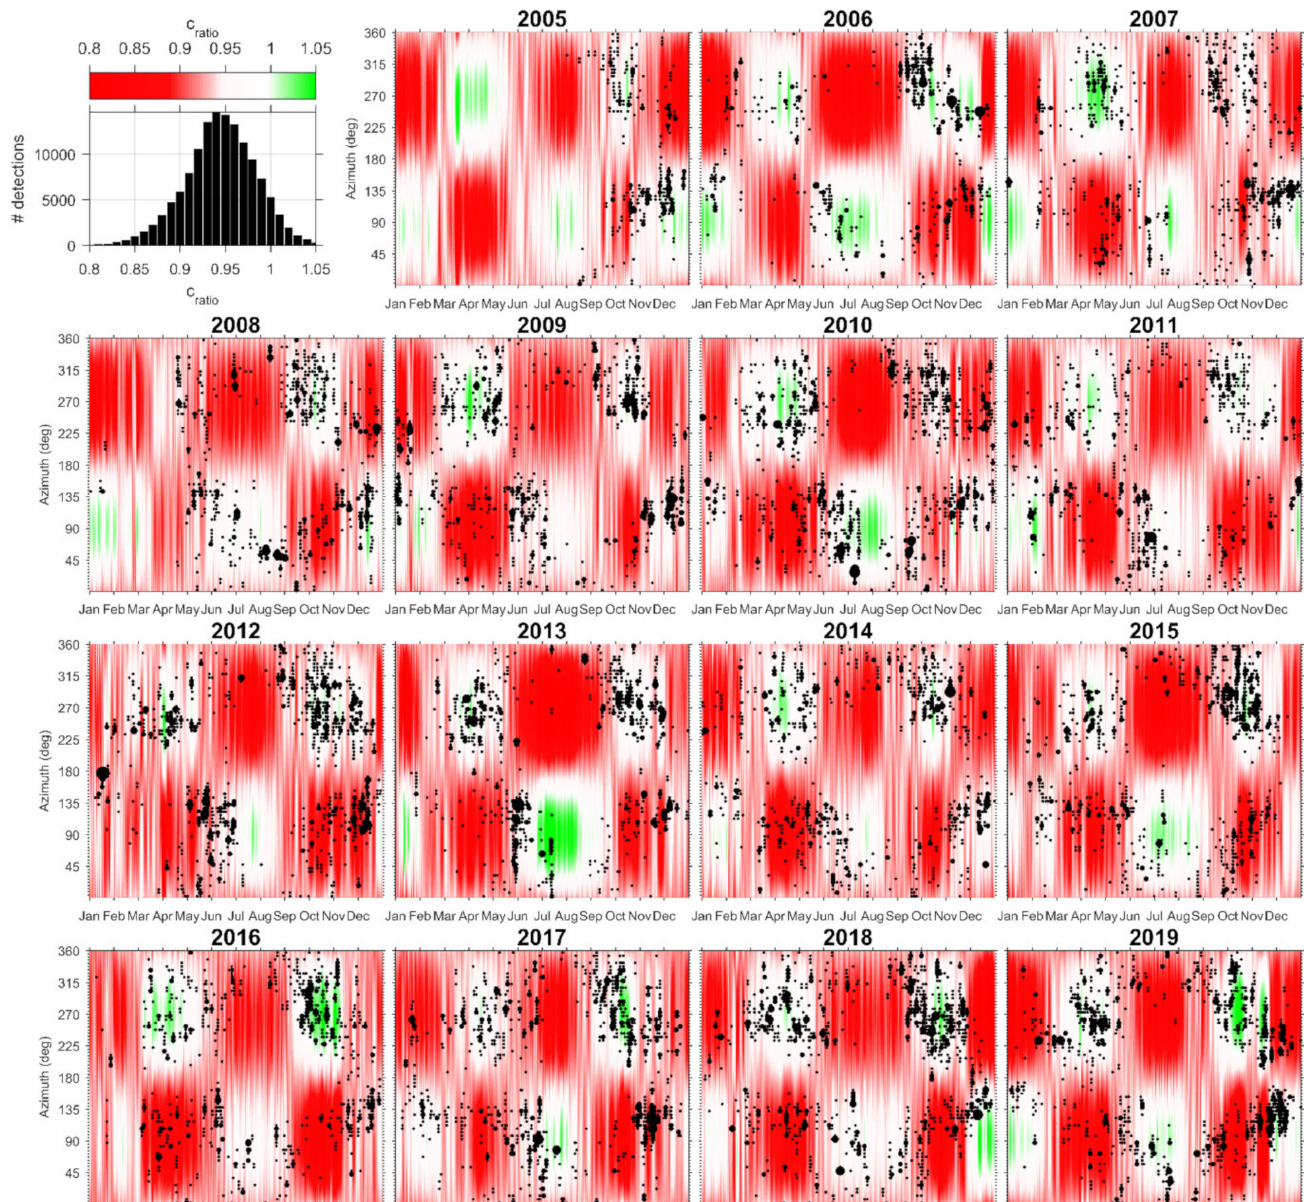
Figure 8. Comparison of the c ratio variability (from red to green between 0.9 and 1.05) with the detections of thunder infrasound that were refracted in the stratosphere (black points whose size is proportional to the number of detections per day and per 5 ◦ interval). Note the absence of data for IS17 in the first half of 2005 and between February and April 2008. The histogram on the top left gives the distribution of c ratio values for all